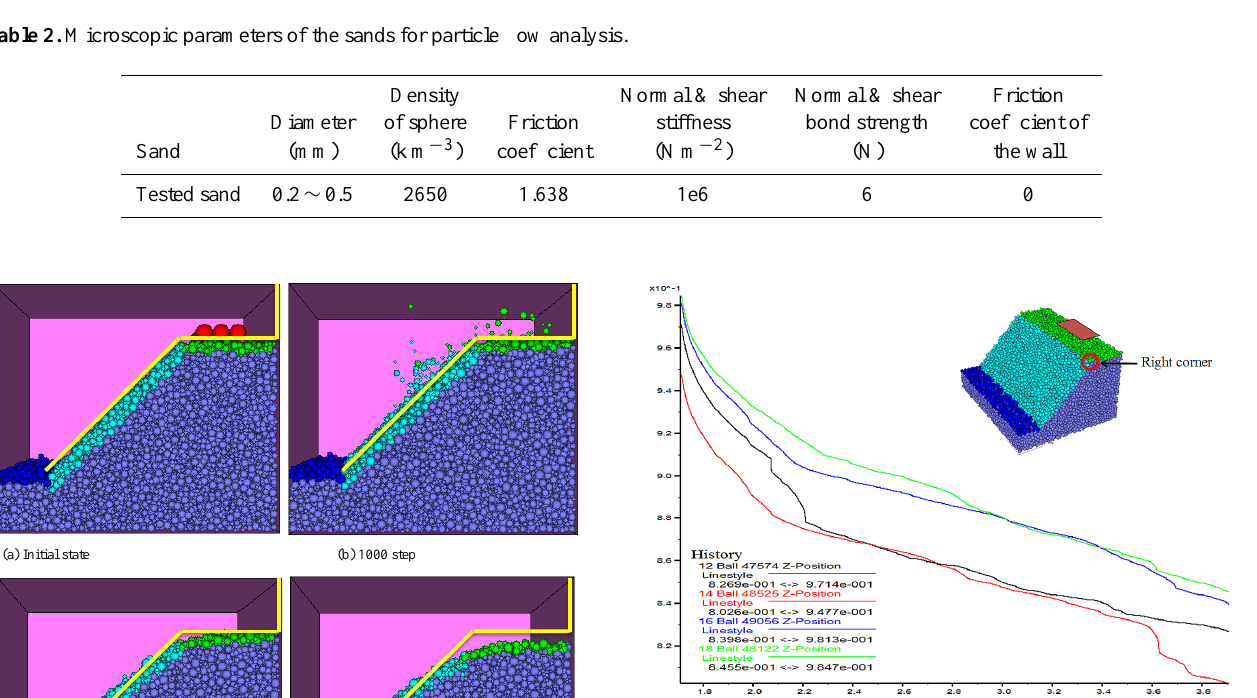
Figure 12. Vertical position history for balls at the right corner of the